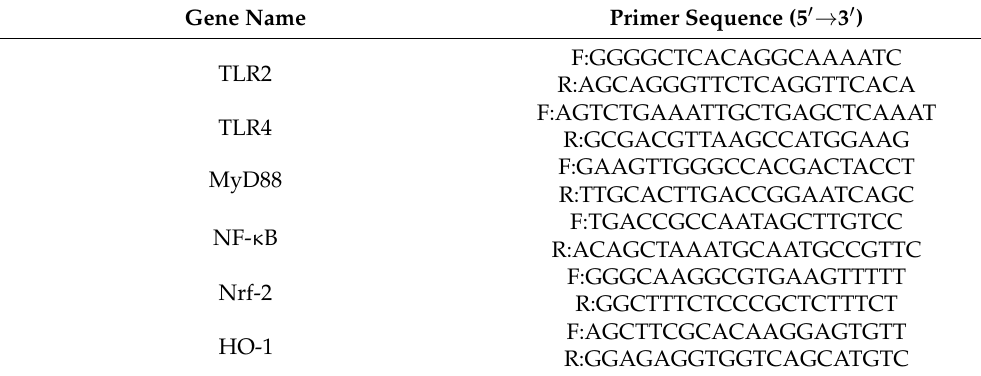
Table 1. Primer sequences used for